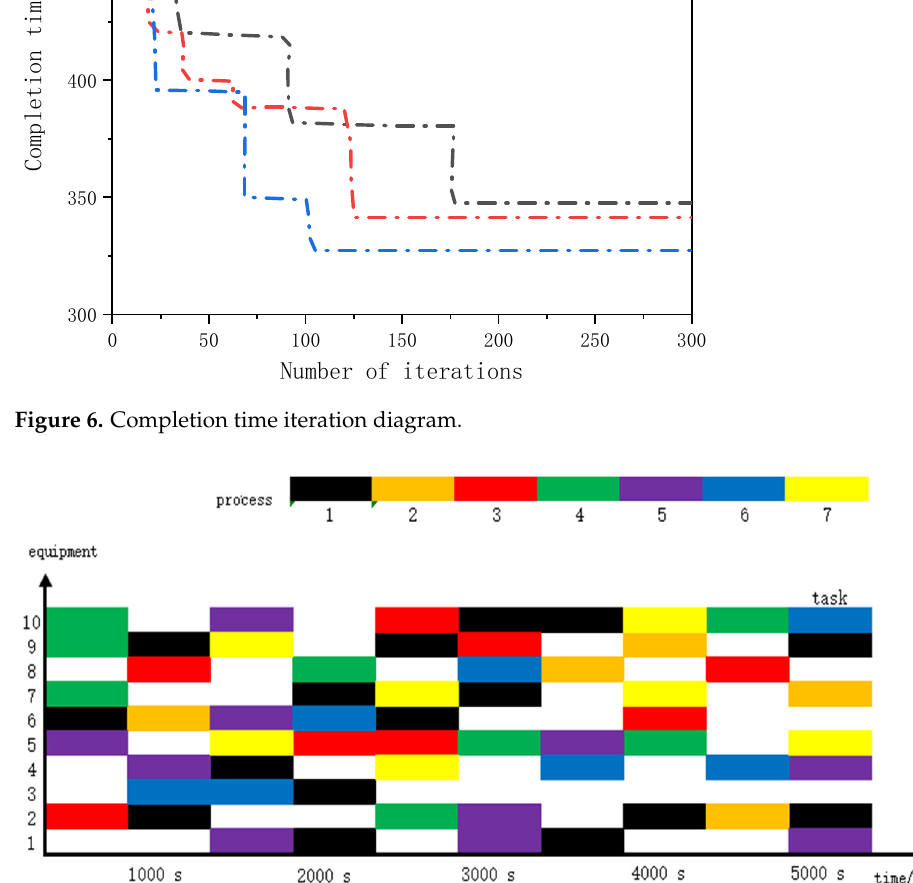
Figure 7. Production plan before scheduling.